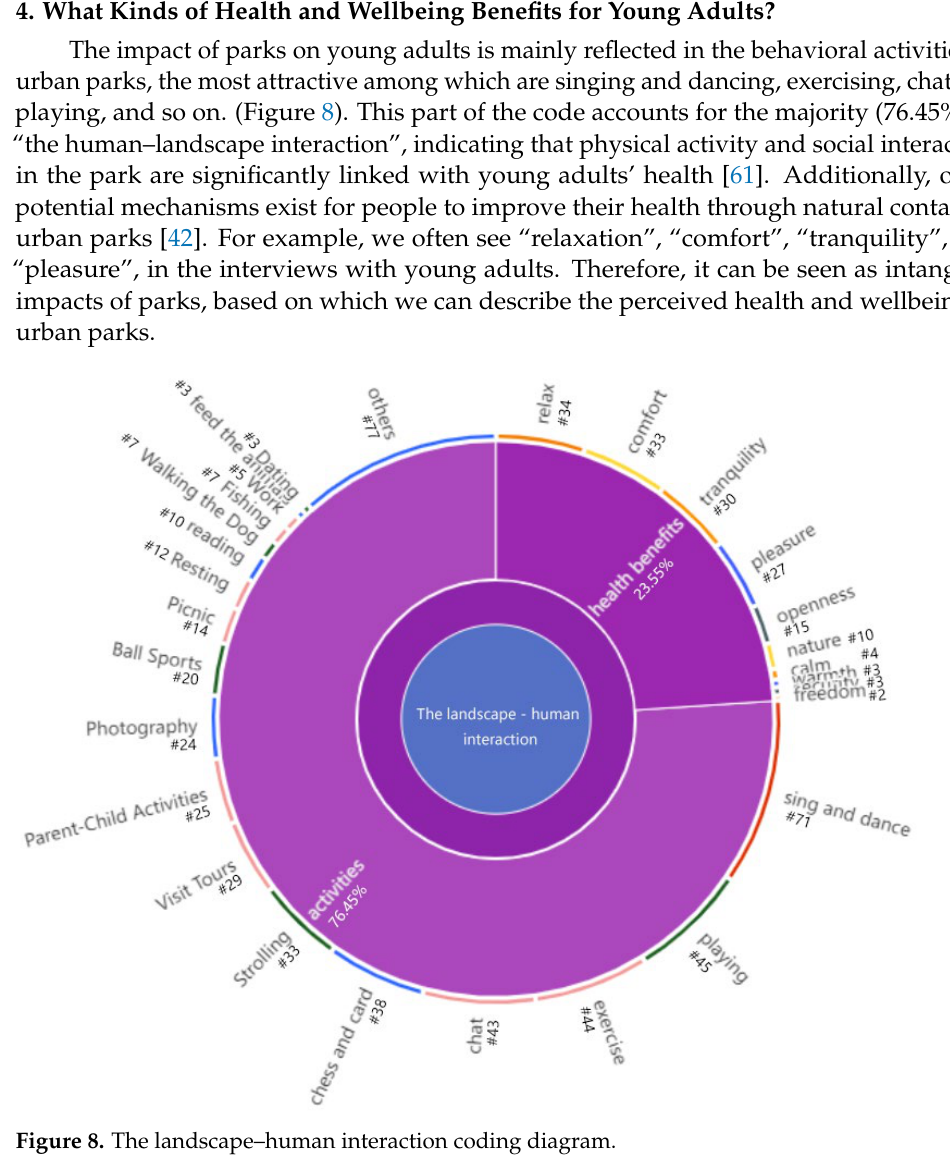
Table 8. Young adults’ place attachment to urban parks.